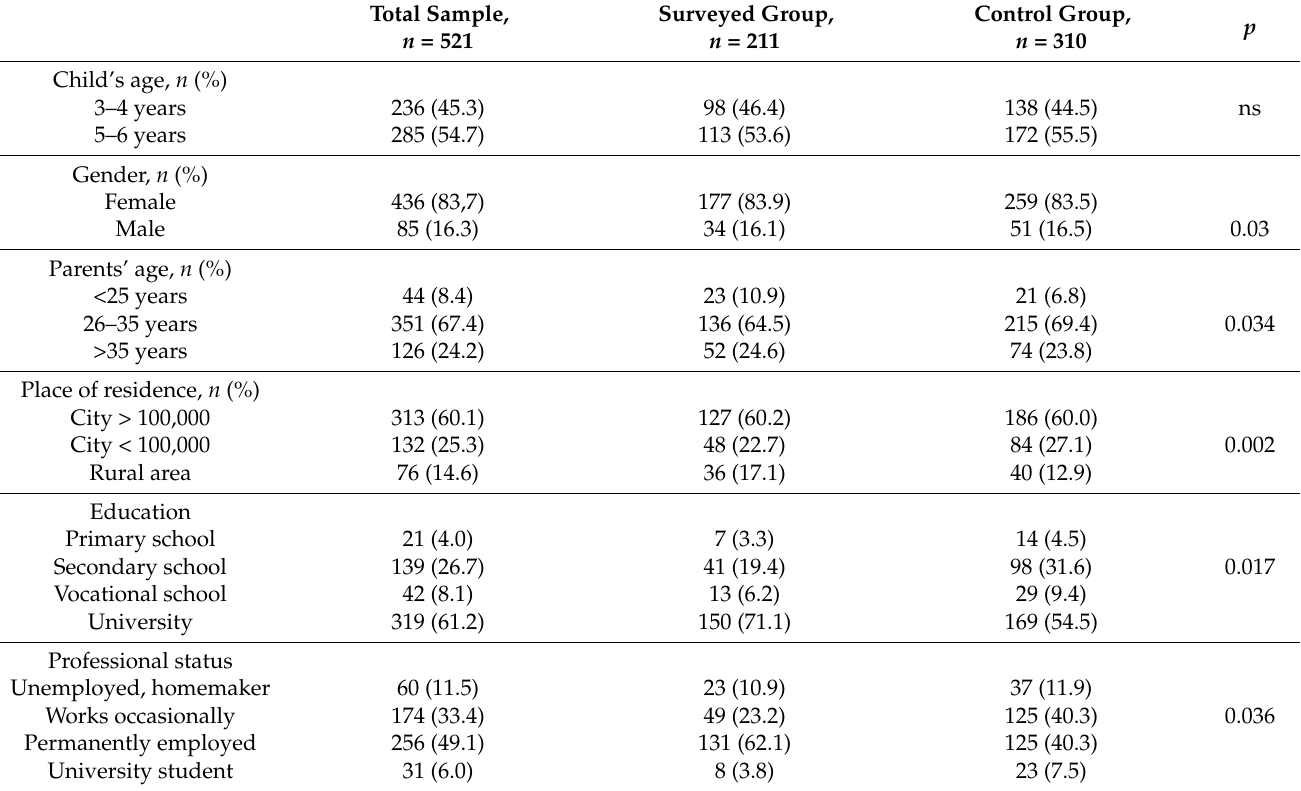
Table 3. Characteristics of the studied population.